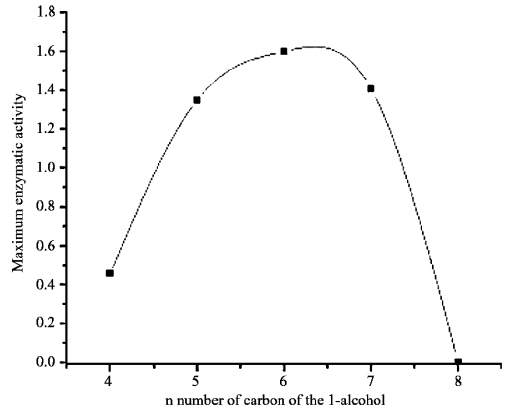
Figure 2. Maximum enzymatic activity, defined as A = V / V 0 (with V initial velocity of the enzymatic reaction in the microemulsion and V 0 initial velocity of the same reaction in the standard buffer solution), observed in microemulsion vs. n, the number of carbon atom of the chain of 1-alcohol used as co-surfactant in dodecane/sodium dodecyl sulfate (SDS)/ n -alcohol/buffer microemulsion [43]. Reprinted from J. Colloid Interface Sci. , 292 , Bauduin, P.; Touraud, D.; Kunz, W.; Savelli, M.P.; Pulvin,